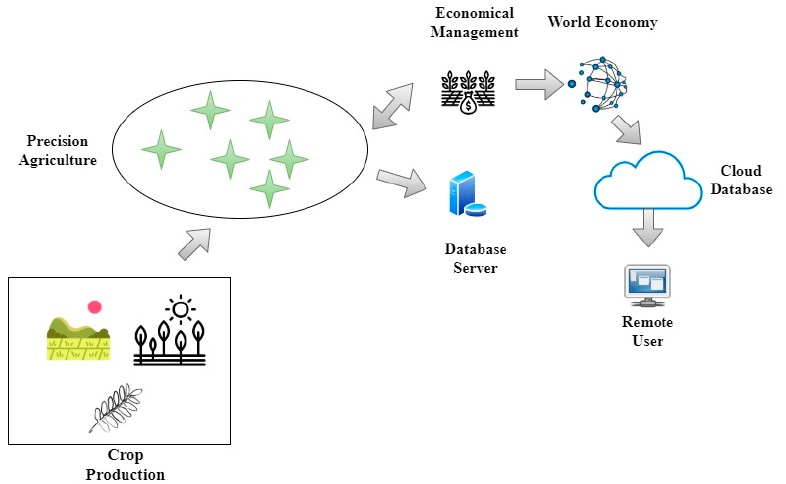
Figure 3. Economic management developed from crop production.